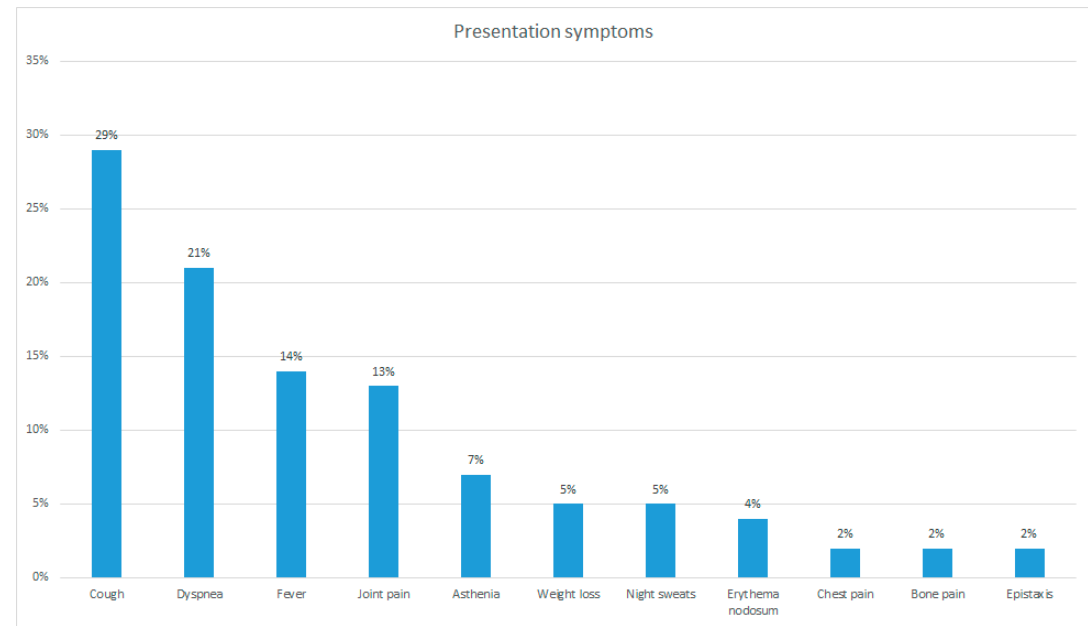
Figure 13. Prevalence of initial symptoms in the population studied.